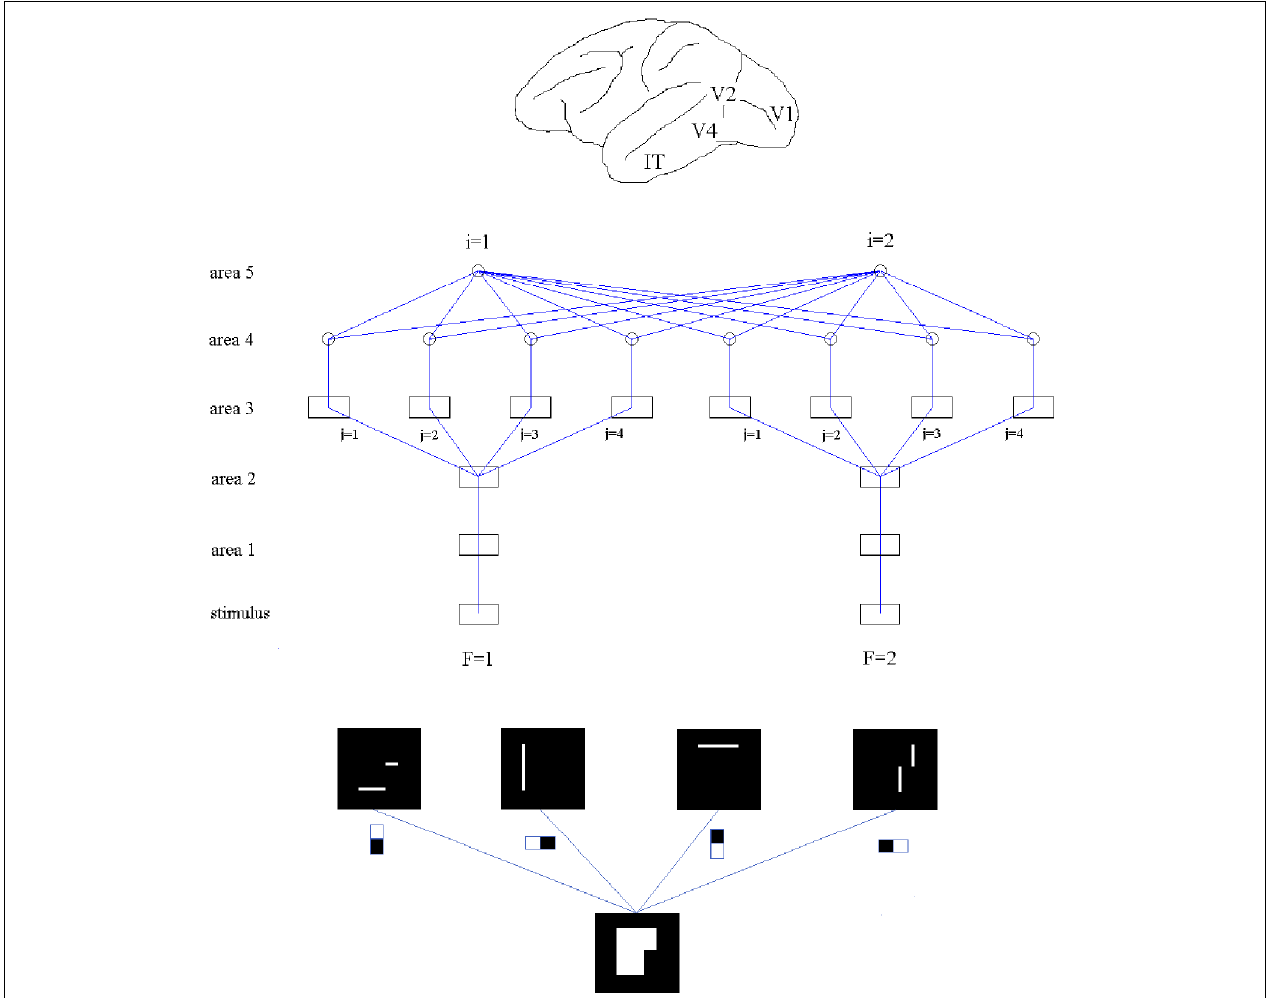
FIGURE 1 | Top: Approximate location of V1, V2, V4, and IT in a macaque brain. Middle: Structure of the studied network, made of five areas. Areas 1–4 are divided into two “feature” channels which, for areas 3 and 4, are further divided into 4 sub-channels associated with each of the employed receptive